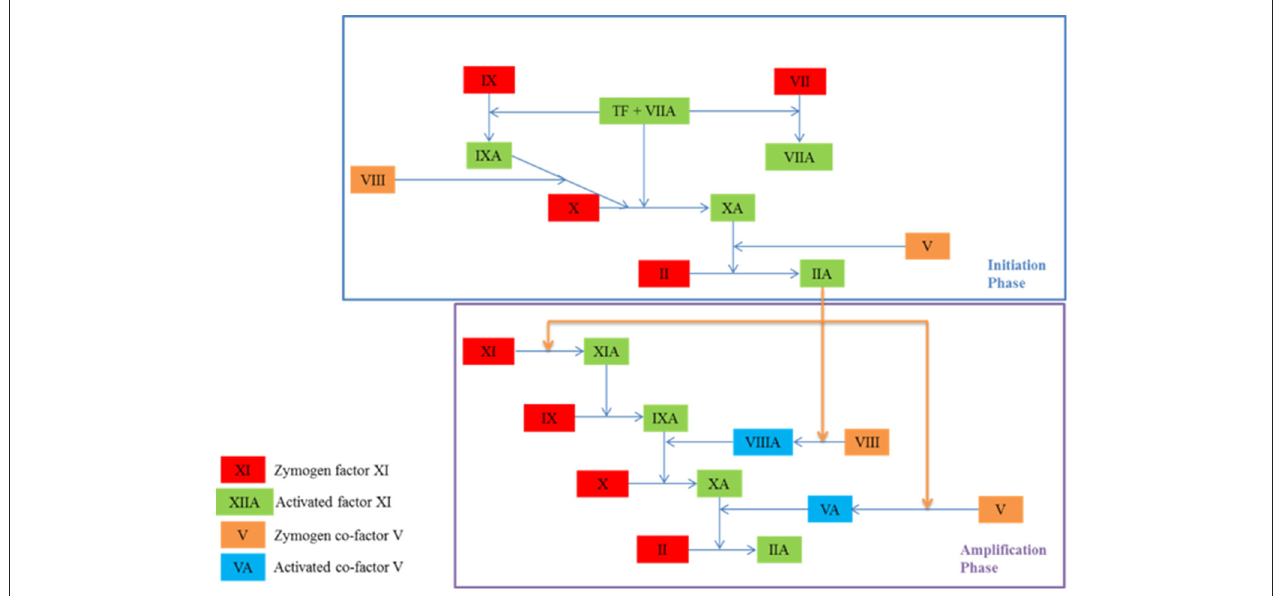
FIGURE 2 | The initiation and amplification phases of coagulation which result in the formation of thrombin (IIA), an enzyme which catalyses the formation of fibrin. A coagulation protein circulates in the blood in an inactive state known as a zymogen and contributes to the clotting process once activated. Co-factors amplify and accelerate the production of activated proteins. They become active in the amplification